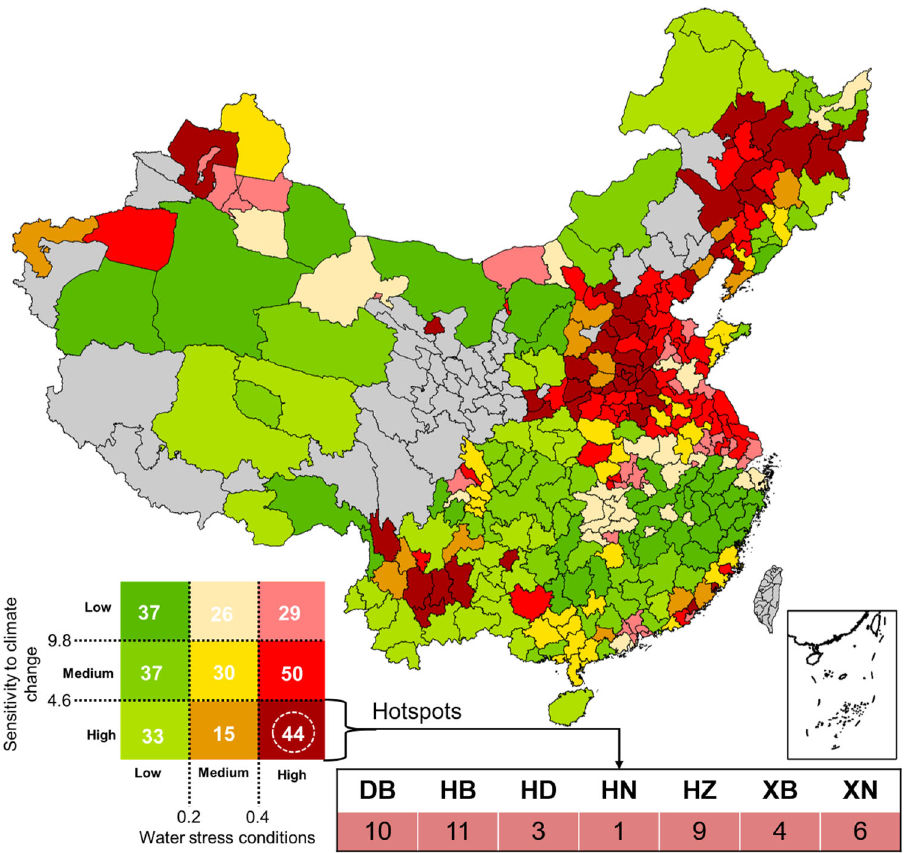
Fig. 2 Co-occurrence of water scarcity and climate sensitivity at the prefecture level. The dark red prefectures are identi fi ed as the vulnerable hotpot prefectures – high water-stressed and high sensitive to climate change according to our de fi nition. Tables are the distributions of the 44 hotspots. DB, HB, HD, HN, HZ, XB, and XN are abbreviations of different districts and the full description are shown in Supplementary Fig. 1. Gray-shaded prefectures are excluded from this